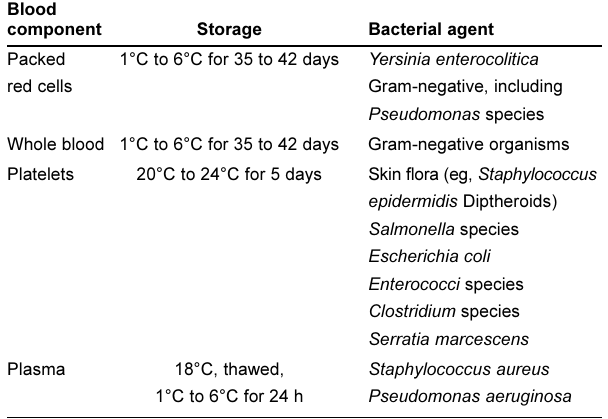
TABLE 4 Bacterial agents associated with acute infection